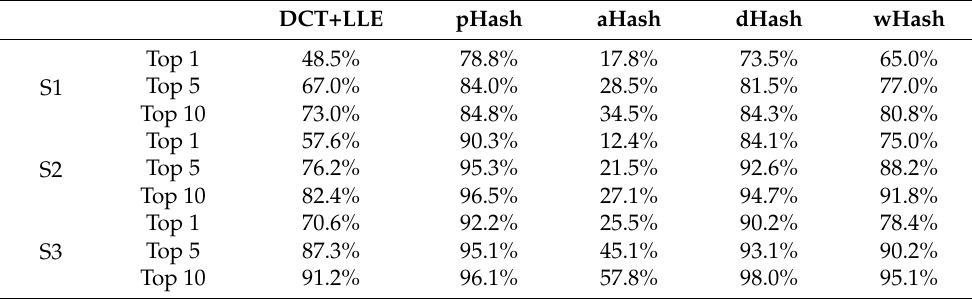
Table A7. Correct matches results for database vs. TS1 comparison—256 bits.